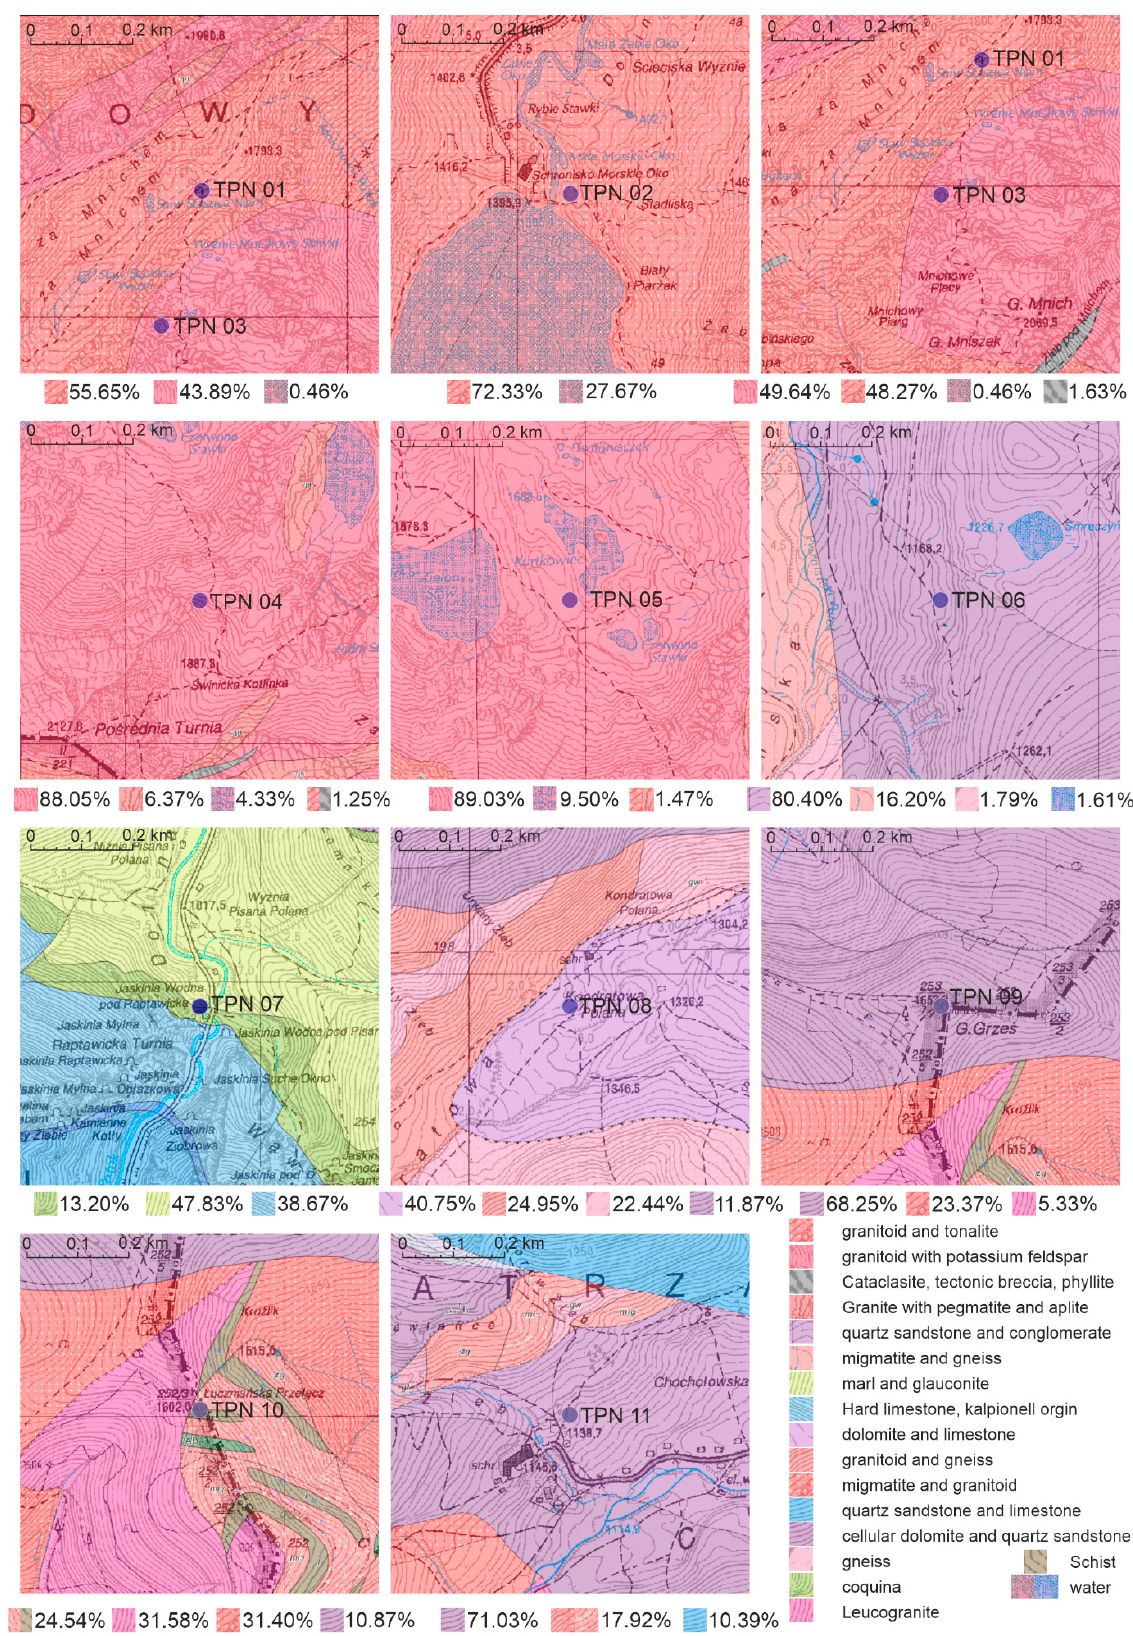
Figure 5. Sampling points with a surrounding area of 0.5km 2 and a separate subdivision of bedrock.